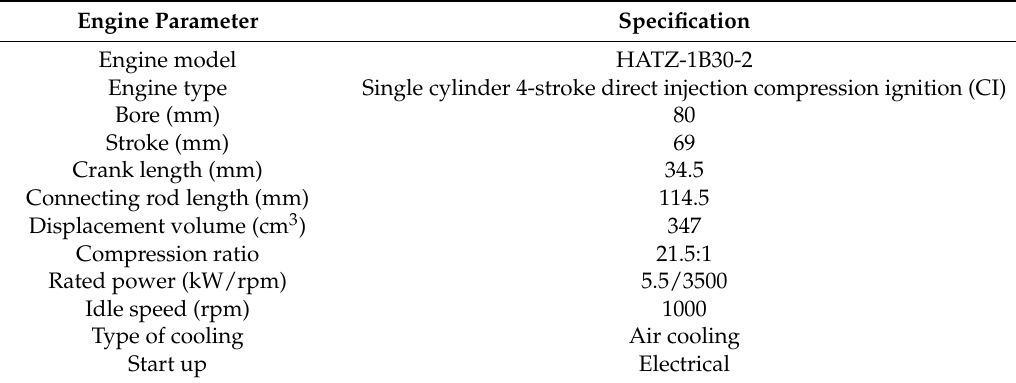
Figure 3. Schematic of the engine experimental setup. Table 1. Specifications of the test